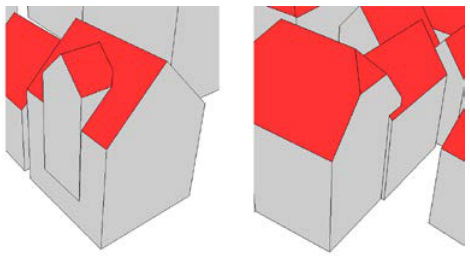
Figure 9. These extrusions in the building façades can be automatically eliminated by the global half-space adjustment.